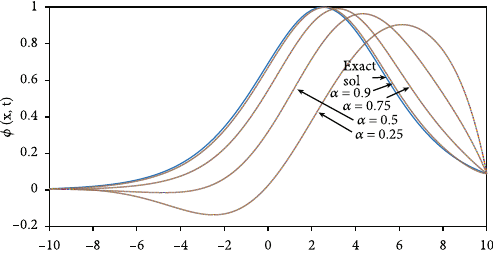
Figure 6: E ff ect of αε ð 0, 1 Þ of time fractional BBMB-equation for